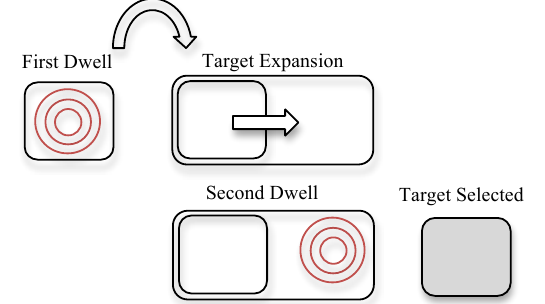
Figure 1: Adapted from NeoVisus, gaze selection components. A short dwell duration leads to the expansion of a second target. By dwelling on the second target the selection can be completed (Tall,